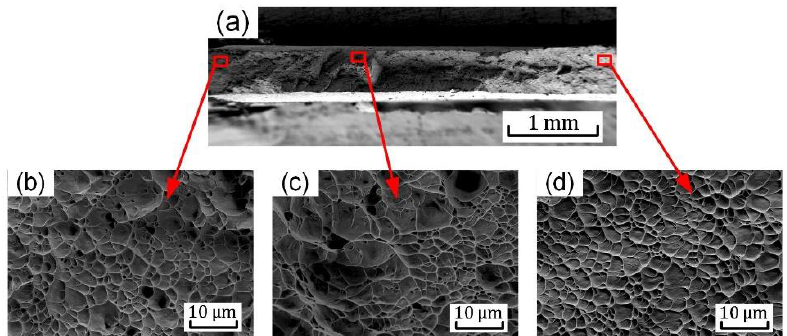
Figure 13. SEM fractography for uniaxial tension sample: ( a ) overall view of the fracture surface; ( b – d ) images at different locations of the fracture surface shown in ( a ).